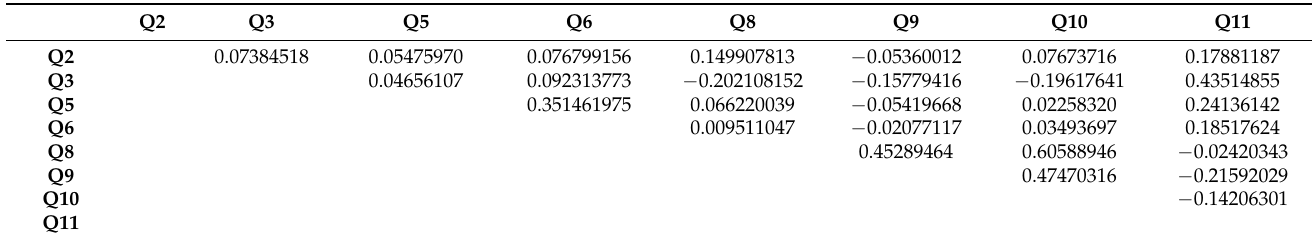
Table 6. Polychoric correlation coefficients between questions Q2, Q3, Q5, Q6, Q8, Q9, Q10 and